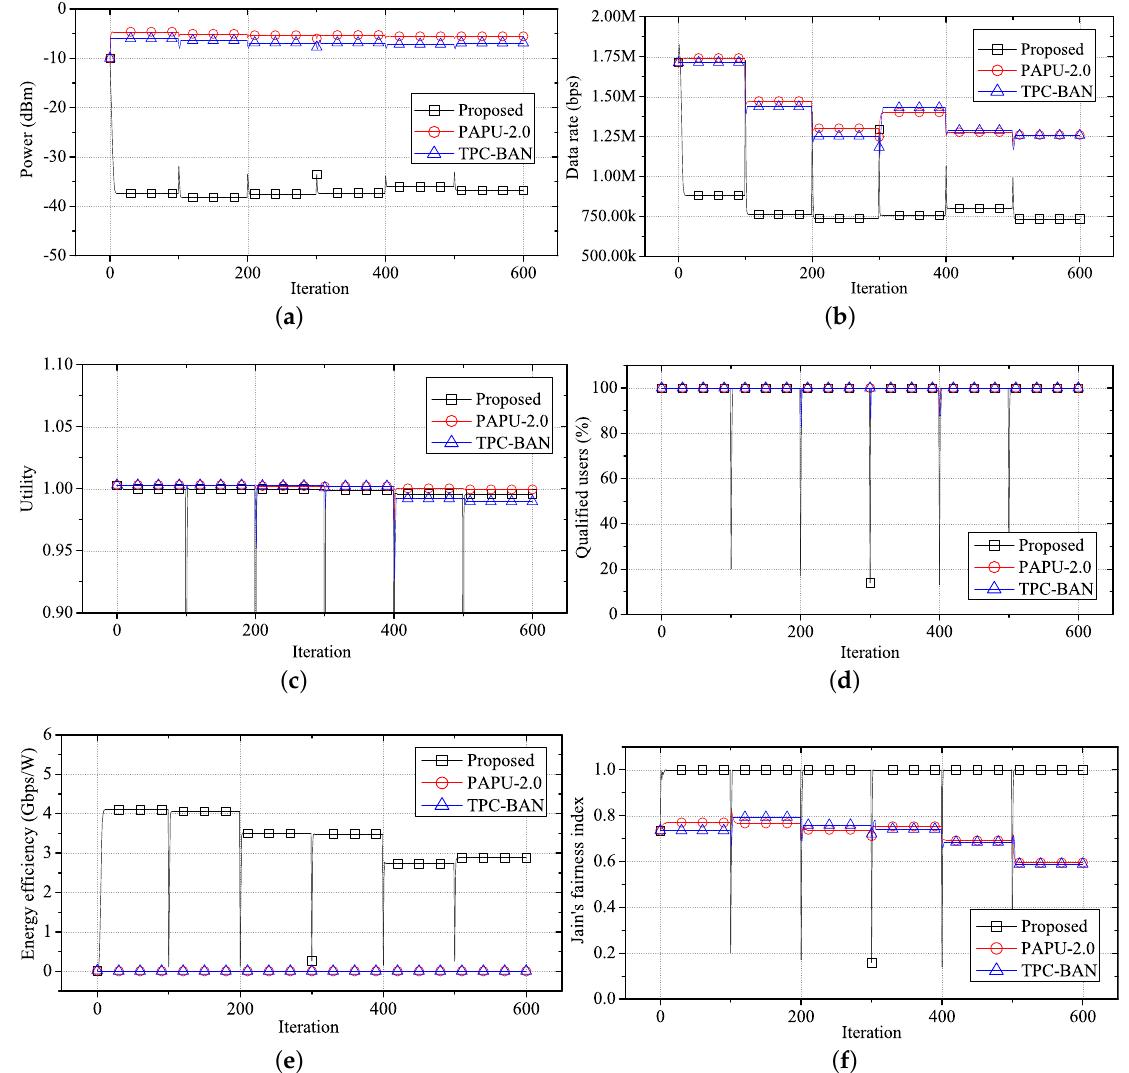
Figure 14. Performance of FTPC-U compared with PAPU and TPC-BAN over time in the entry environment. ( a ) Change in average transmit power; ( b ) change in average data rate; ( c ) change in average utility; ( d ) change in qualified users; ( e ) change in average energy efficiency; ( f ) change in